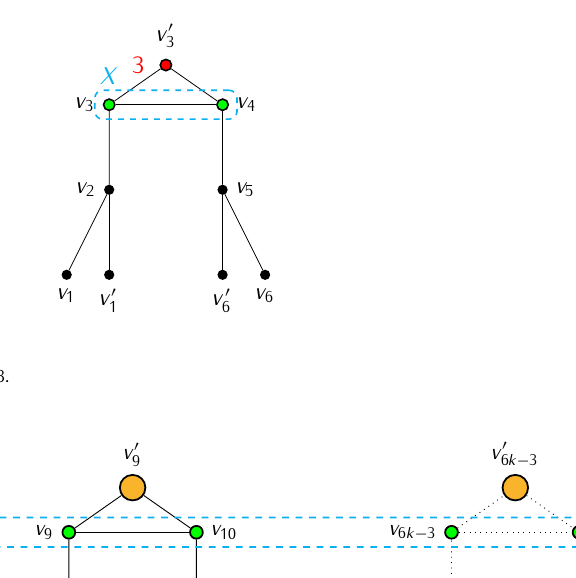
Figure 1: A graph H with ir( H ) = 2 and γ